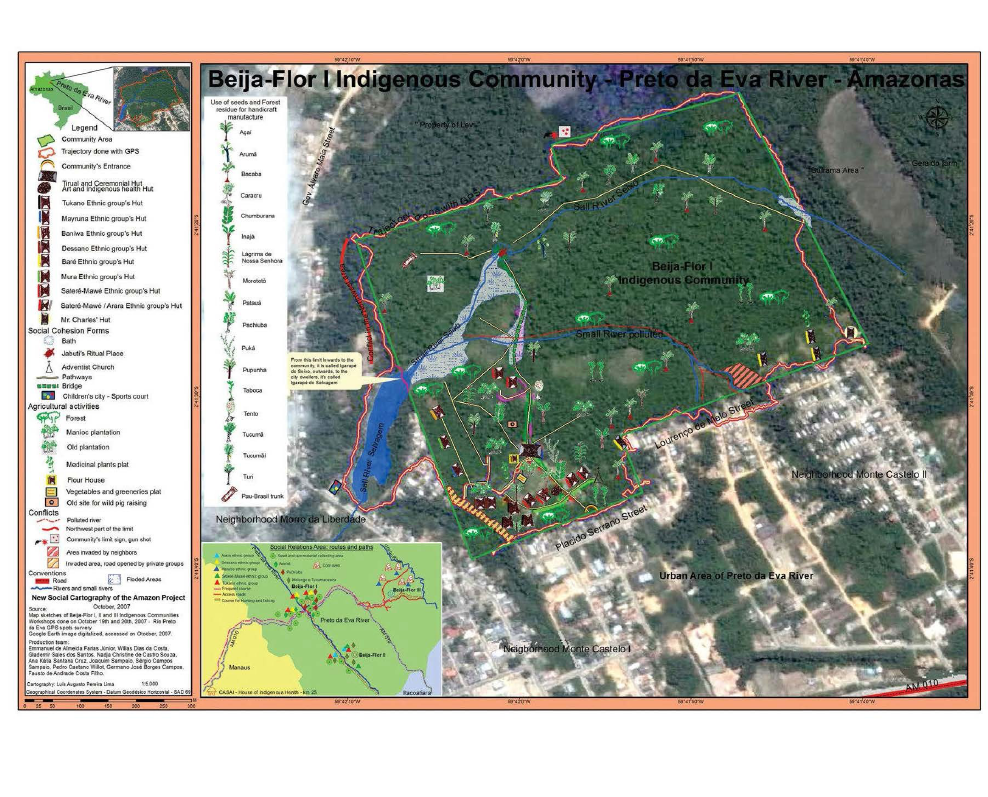
Figure 4: Community mapping in Beija-Flor I, Preto de Eva River, Amazonas, Brazil. Source: A New Social Cartography: Defending Traditional Territories by Mapping in the Amazon (de Almeida, Dourado, and Bertolini 2019, 50). Available at https://notanatlas.org/maps/a-new-social-cartography/. Image reproduced under the Fair Use Doctrine and in accordance with the Creative Commons Attribution 4 license assigned to this work: